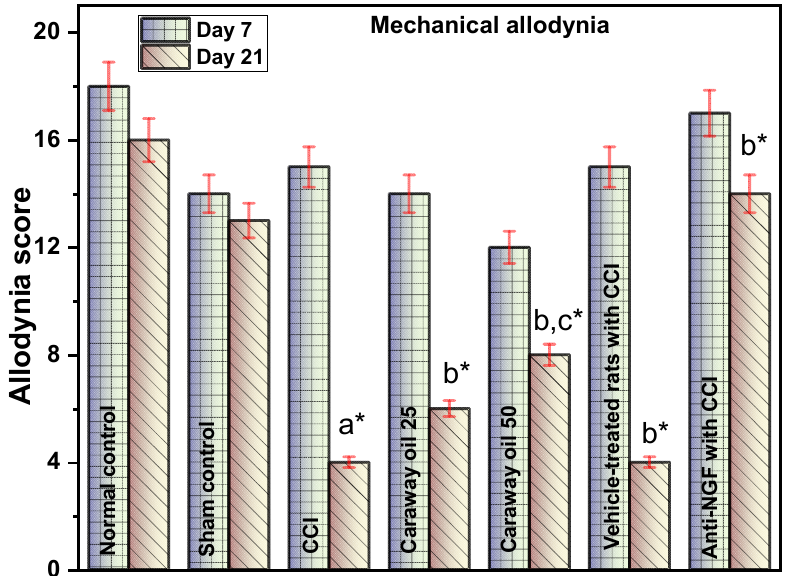
Figure 2. Effect of Caraway oil on CCI-induced mechanical allodynia assessed by Von Frey hair test. It is represented as mean ± SEM; n = 6. a p ≤ 0.05 against sham control correspondent to the same day. b p ≤ 0.05 against CCI comparable to the same day. c p ≤ 0.05 versus caraway oil and anti-NGF in CCI compatible to the same day. * represents p -value ≤ 0.05.